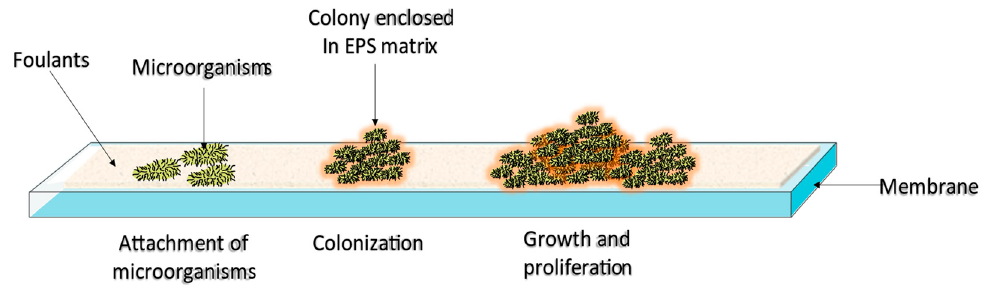
Figure 2. Biofouling mechanism.